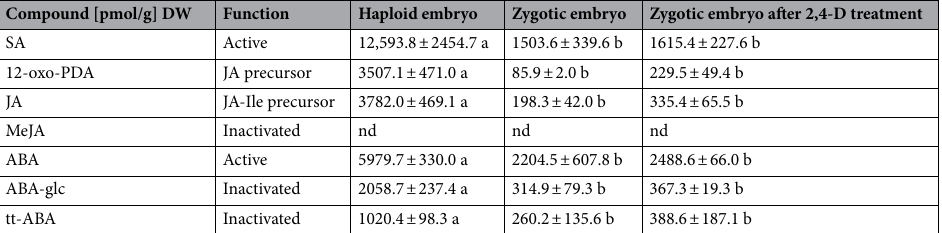
Table 4. Stress-related hormones in cv. ‘Akt’ embryos. Values are means of three replicates ± standard error. Means indicated by the same letter do not significantly differ at P < 0.05 according to one-way ANOVA and post hoc Duncan’s test.